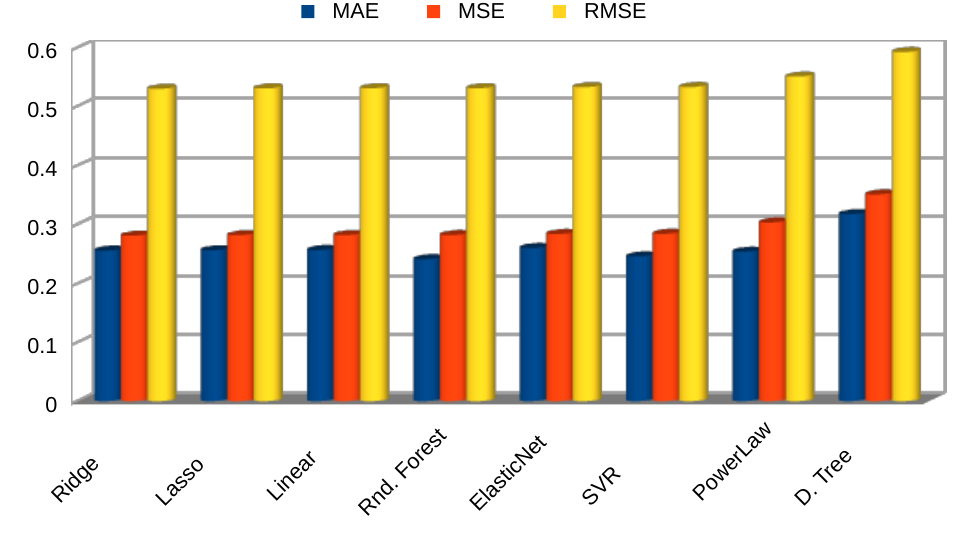
Figure 10. Model errors [ms − 1 ].